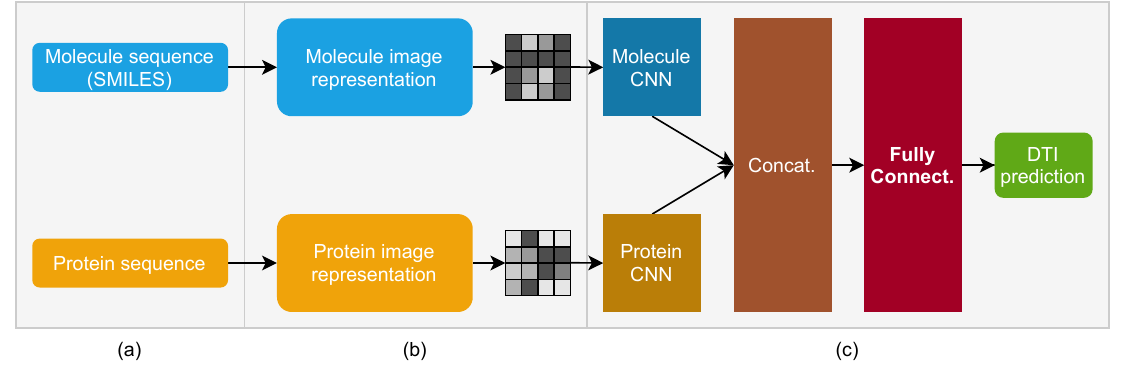
Figure 1. Molecule and protein sequence to image transformer DTI prediction model: ( a ) input: moleculesequence(SMILES)andproteinsequence; ( b )representation: moleculeandproteinsequences are mapped to image pixels; ( c ) CNN-based deep neural network for DTI prediction: molecule and protein input images are fed into molecule and protein CNNs, whose output is concatenated and fed into a dense, fully connected network, whose output is the DTI